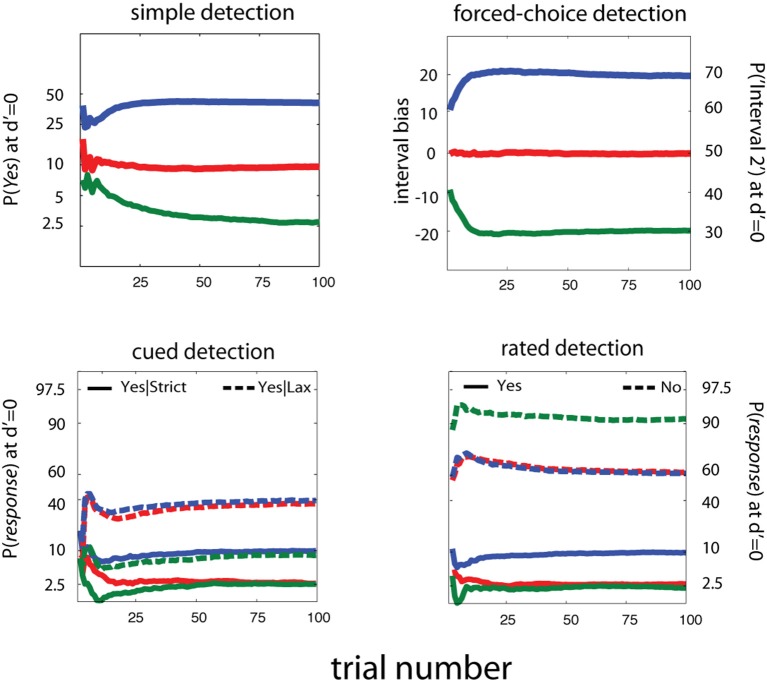
Estimating Decision Criteria. For invariance of sensitivity threshold estimates across detection tasks, it's necessary to estimate and account for decision criteria across different response states. Here we present estimates of response probabilities at d′ = 0, for simple, cued, rated, and forced-choice detection tasks. It's apparent that, unlike previous adaptive methods developed for YN and FC tasks, these methods can reliably distinguish a broad range of decision-level behaviors. For simple and cued detection, 25 trials are sufficient for the qYN and qYNC methods to distinguish Yes response rates that correspond to different response states: 2.5, 10, and 40%. For rated detection, the corresponding response rates are 2.5, 10, and 40, for Yes Responses and 90 and 60% for No responses. Simulation results for the qFC are presented for un-biased (red) and interval-biased (green, blue) response states in forced-choice detection (see Figure 4). When presented with a blank stimulus in both intervals, the biased observers responded Interval 2 with probabilities of 70 or 30% (interval bias of ±20%). Similarly to the methods developed for the YN tasks, the qFC can reliably distinguish response behavior corresponding to biased or unbiased forced-choice detection.